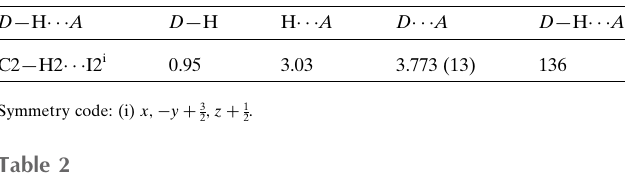
Table 1 Hydrogen-bond geometry (A˚ , (cid:2) ).